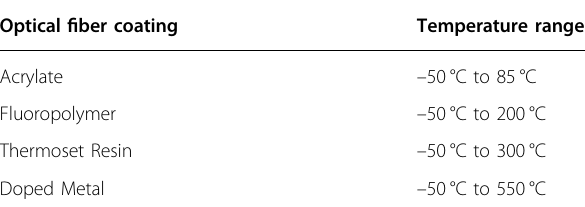
Table 10 Fiber-based temperature measurement range Optical fi ber